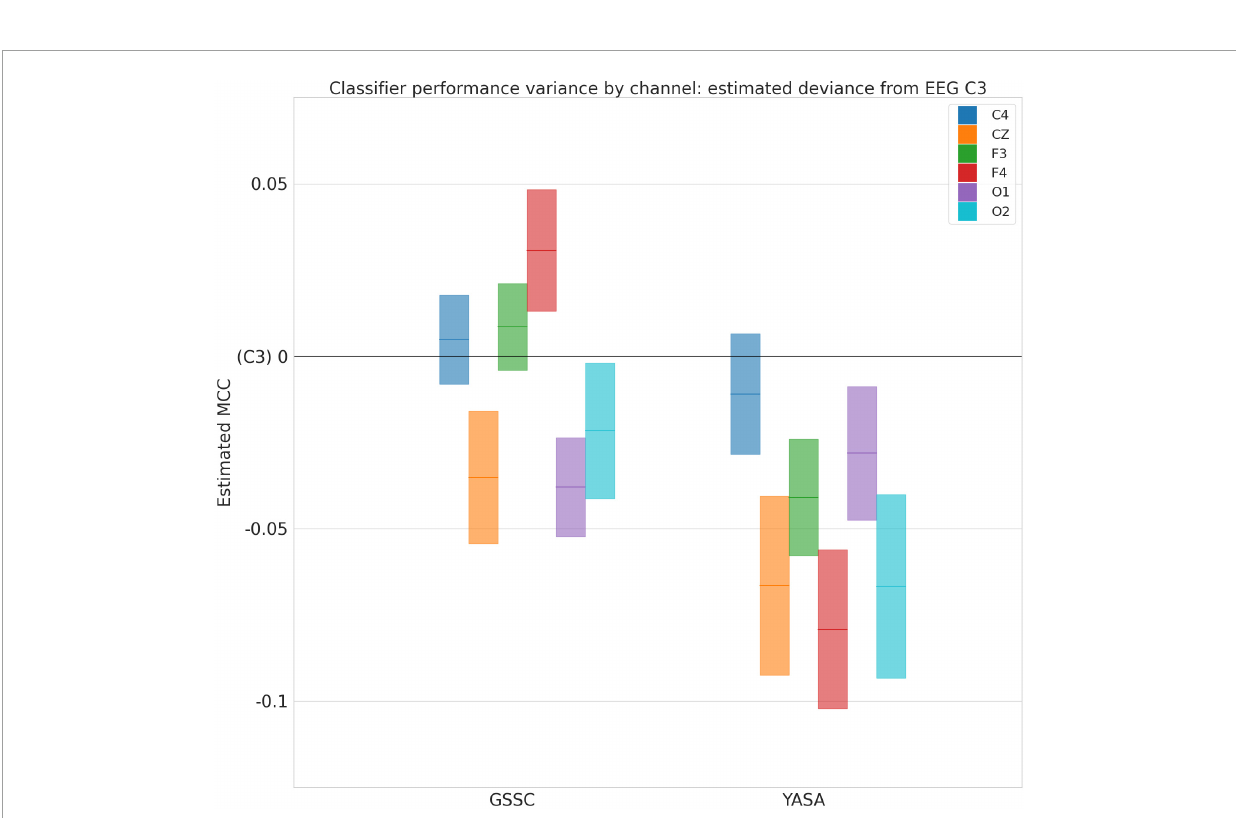
FIGURE8 Performance variance across channels. Deviance in Matthews Correlation Coeffecient for different electroencephalogram (EEG) channels and Greifswald Sleep Stage Classifier (GSSC) and YASA classifiers from baseline of EEG C3, as estimated by a linear mixed effects model. Blocks show 95% confidence intervals around the estimated deviance (solid, colored